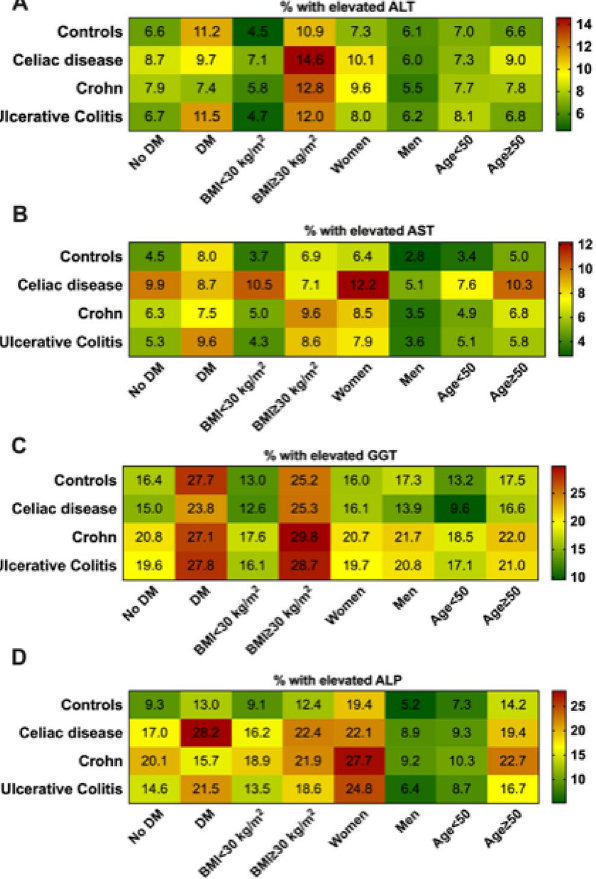
Figure 3. Frequency of elevated liver enzymes in subcohorts of patients with celiac disease, Crohn’s disease, and ulcerative colitis compared to healthy controls. Relative frequencies (%) are shown and visualized by a color coding (right panel). ALT alanine aminotransferase, AST aspartate aminotransferase, ALP alkaline phosphatase, AST aspartate aminotransferase, GGT gamma-glutamyl transferase, BMI body mass index (kg/m 2 ), DM diabetes